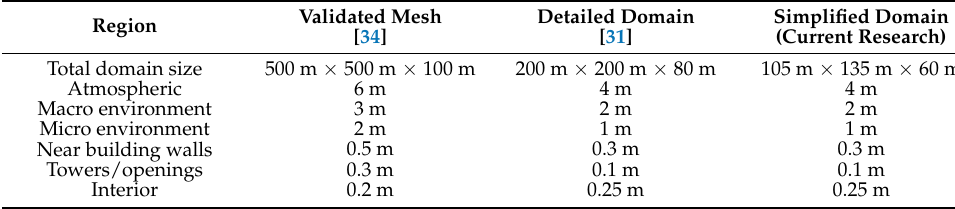
Table 1. General cell sizes of the simulated meshes.